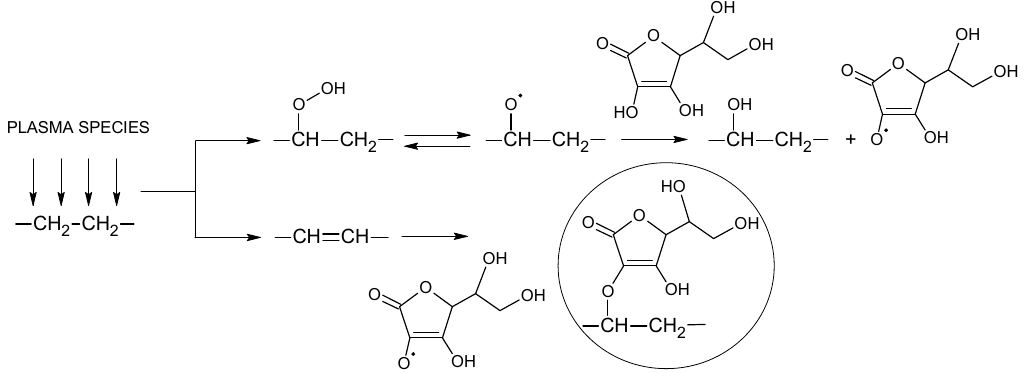
Figure 1. Scheme of ascorbic acid (ASA) grafting on low ‐ density polyethylene (LDPE) via plasma